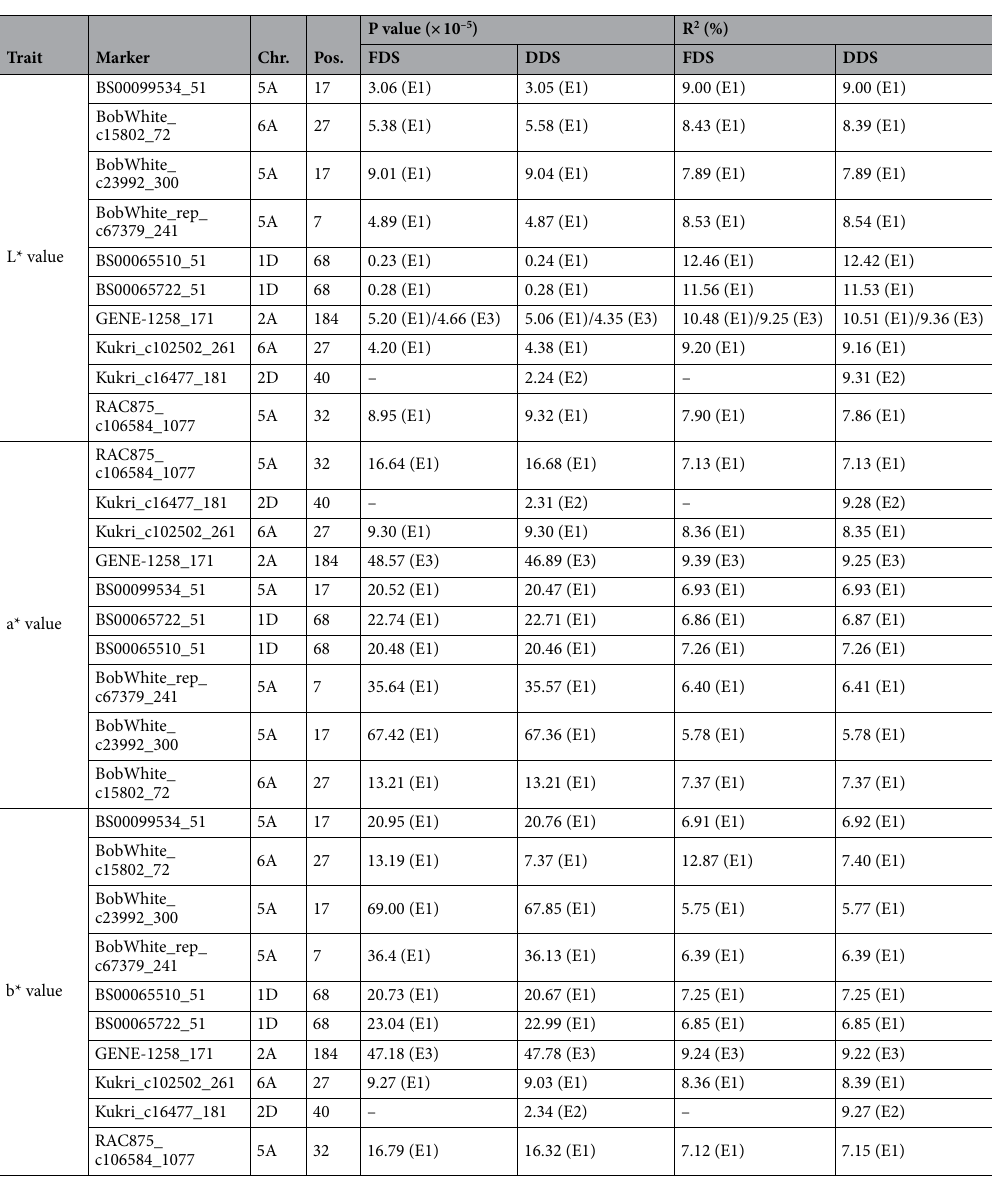
index, a* value the redness index, b* value the yellowness index, FDS fresh dough sheet, DDS dry dough